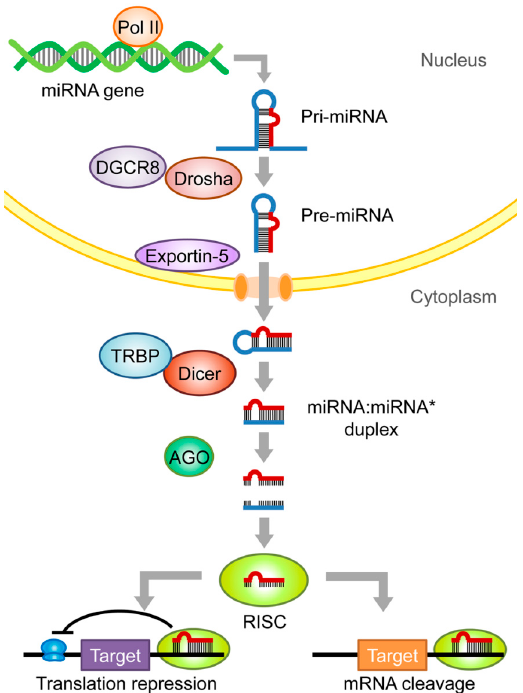
Figure 1. MicroRNA (miRNA) biogenesis. This schematic diagram illustrates the canonical pathway of miRNA biogenesis. The miRNA gene is transcribed by RNA polymerase II (Poly II) to generate the primary miRNA (pri-miRNA) that forms hairpin structures. The long pri-miRNA is then processed by Drosha and DiGeorge syndrome critical region 8 (DGCR8) into the shorter precursor miRNA (pre-miRNA), which is then exported to the cytosol with the help of exportin-5. The pre-miRNA is further cleaved by Dicer and transactivation response element RNA-binding protein (TRBP), yielding the miRNA:miRNA* duplex molecule, which is loaded into argonaute (AGO) to unwind and form the functional RNA-induced silencing complex (RISC). The mature miRNA then binds to the seed sequences on the 3 (cid:48) untranslated region (3 (cid:48) UTR) of the target mRNA, leading to its translation repression or cleavage and thereby